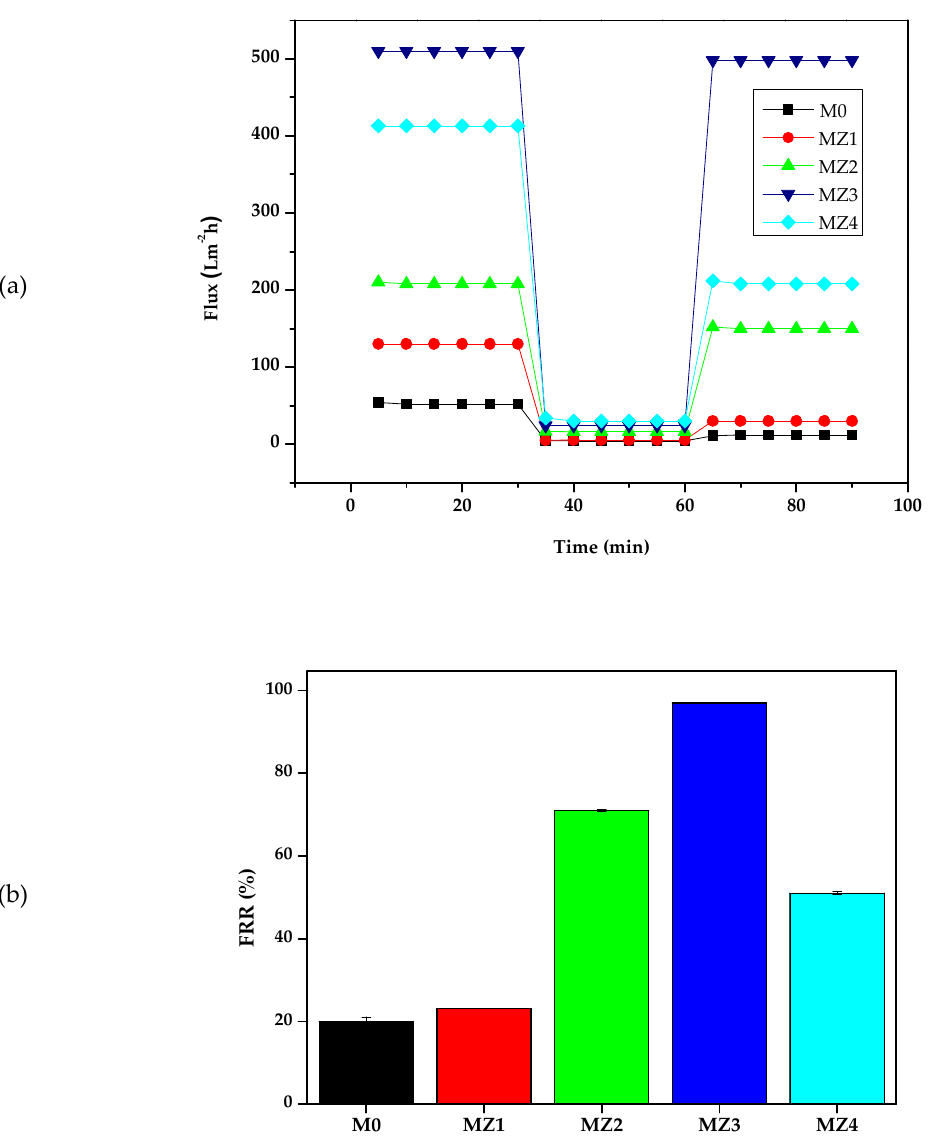
Figure 11. ( a ) Flux-fouling-recovery cycle; ( b ) the resultant water flux recovery ratio for the prepared membranes.